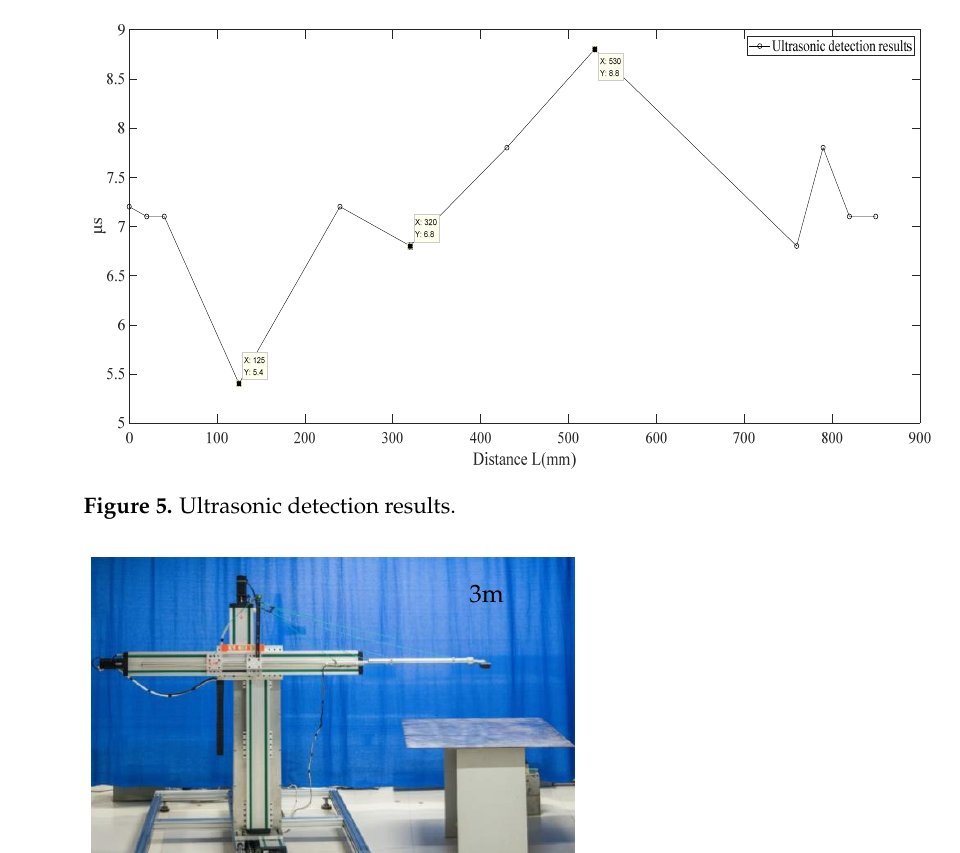
Figure 6. Three-axis magnetic intensity detection system.